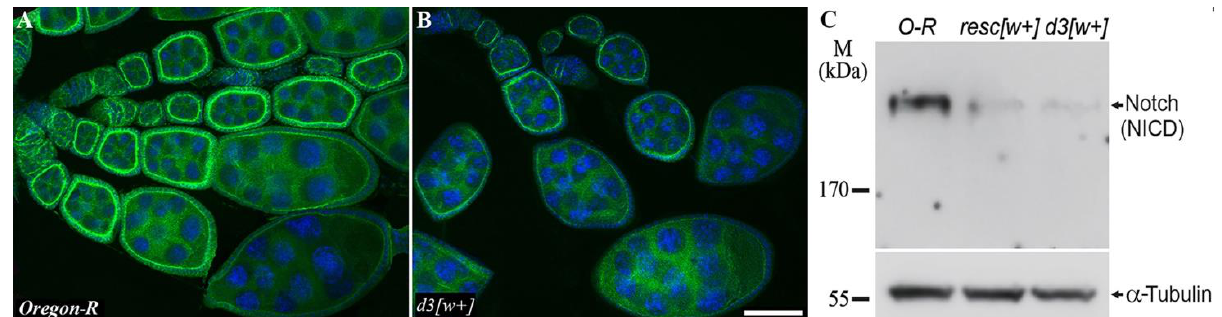
Figure 4. Protein localization and expression in the oogenesis of the mutants and Oregon-R flies. ( A , B ). Staining with the anti-Notch intracellular domain antibody uncovered no difference in the Notch localization between Oregon-R ( A ) and d3[w+] ovaries ( B ), but in d3[w+] ovaries, the intensity of staining is weaker and close to the background. The scale bar is 10 µm. ( C ). Western blot analysis of Notch protein expression in ovaries of Oregon-R (control), resc[w+], and d3[w+] imago females. Staining with antibodies to tubulin serves as a loading control.